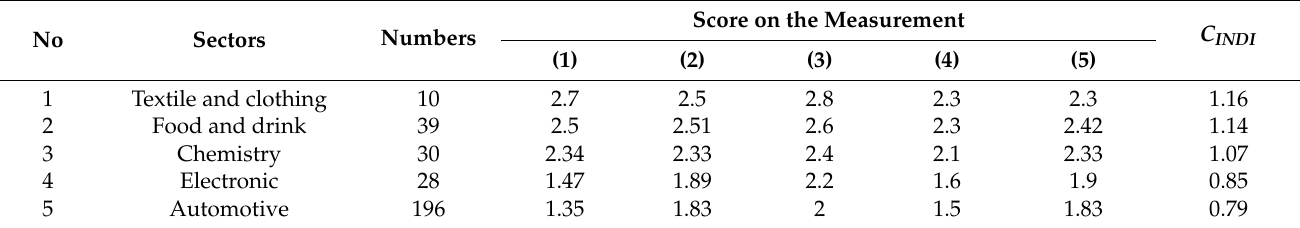
Table 5. C INDI score for the five priority industrial sectors scores